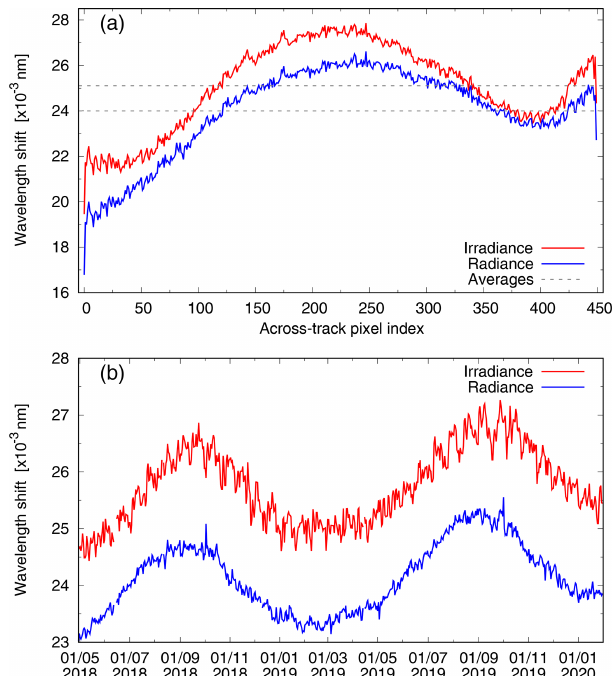
Figure 2. Wavelength calibration shifts w s for the NO 2 fit win- dow (405–465nm) of the TROPOMI irradiance (red) and radiance (blue), where the latter is an average over the tropical latitude (TL) range. (a) Shifts for 1 July 2018 (radiance orbit 03711, with irra- diance from orbit 03718) as a function of the across-track ground pixel index; the dashed horizontal lines are the across-track aver- ages, with the exception of the outer rows. (b) Time evolution of the across-track average